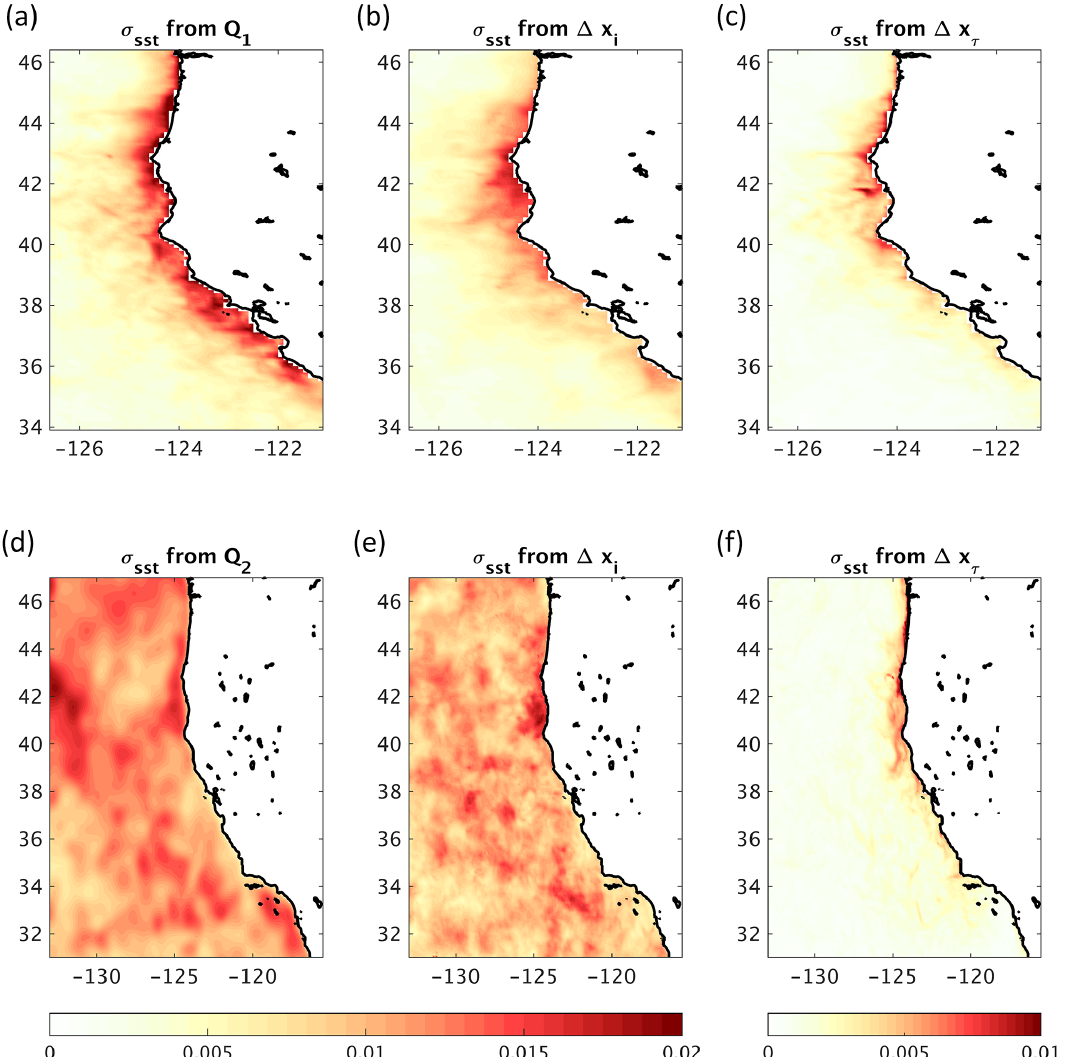
Figure A1. The standard deviation of the additional artificial source of model error added to experiments S2: (a) the expected error based on Q 1 , (b) derived from (cid:49) x i using Q 1 during S2, and (c) derived from (cid:49) x τ using Q 1 during S2. (d) The expected error based on Q 2 , (e) same as (b) but using Q 2 during S2, and (f) same as (c) but using Q 2 during S2. The color bar on the left corresponds to panels (a) , (b) , (d) , and (e) , while the color bar on the right is for (c) and (f)